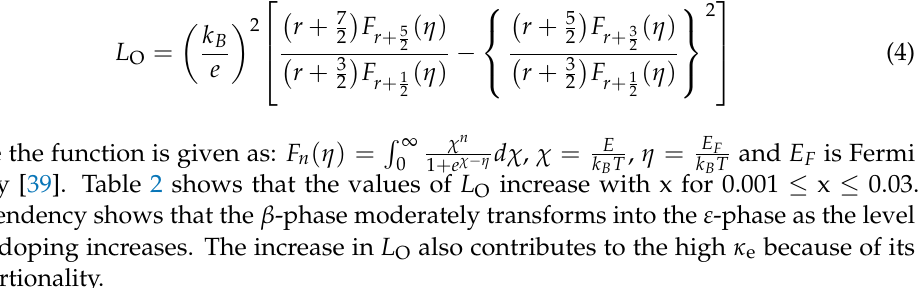
Figure 9. ZT of β -Fe 1−x Ni x Si 2 (0 ≤ x ≤ 0.03) with respect to temperature, where the inset plots the data for x = 0.